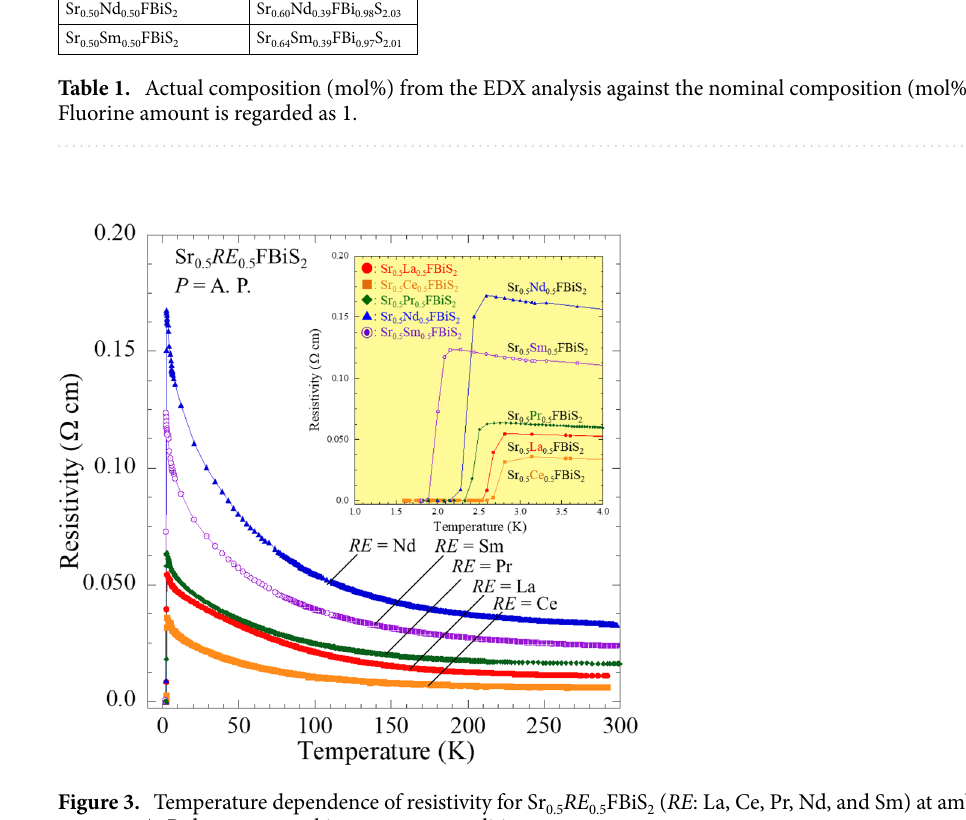
Figure 3. Temperature dependence of resistivity for Sr 0.5 RE 0.5 FBiS 2 ( RE : La, Ce, Pr, Nd, and Sm) at ambient pressure. A. P. denotes an ambient pressure